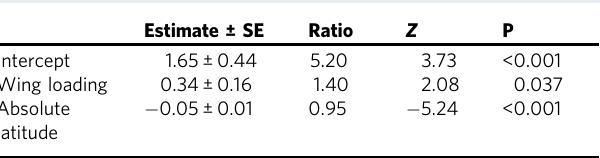
Results of a beta regression with logit link function and phylogenetic covariance structure. The ratios signify, for the intercept, the ratio of black to non-black predicted by the model at the baseline values (mean wing loading and a latitude of 0°), and, for each predictor variable, the ratio of black to non-black predicted by one unit increase divided by the ratio at the baseline. N = 49 species.